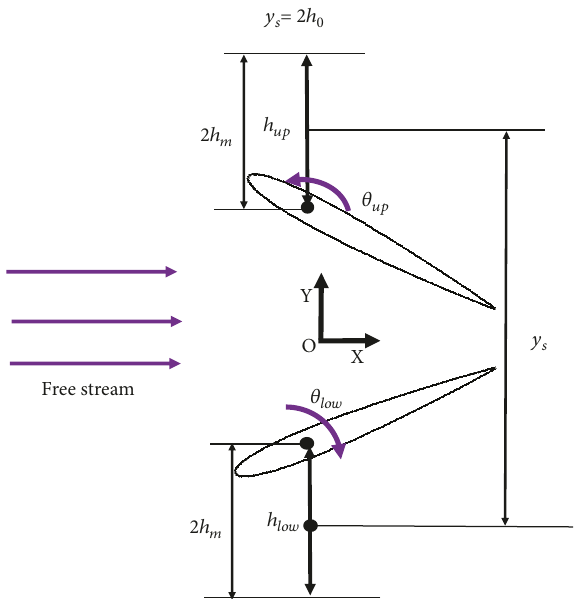
Figure 1: The schematic of the biplane counter- fl apping